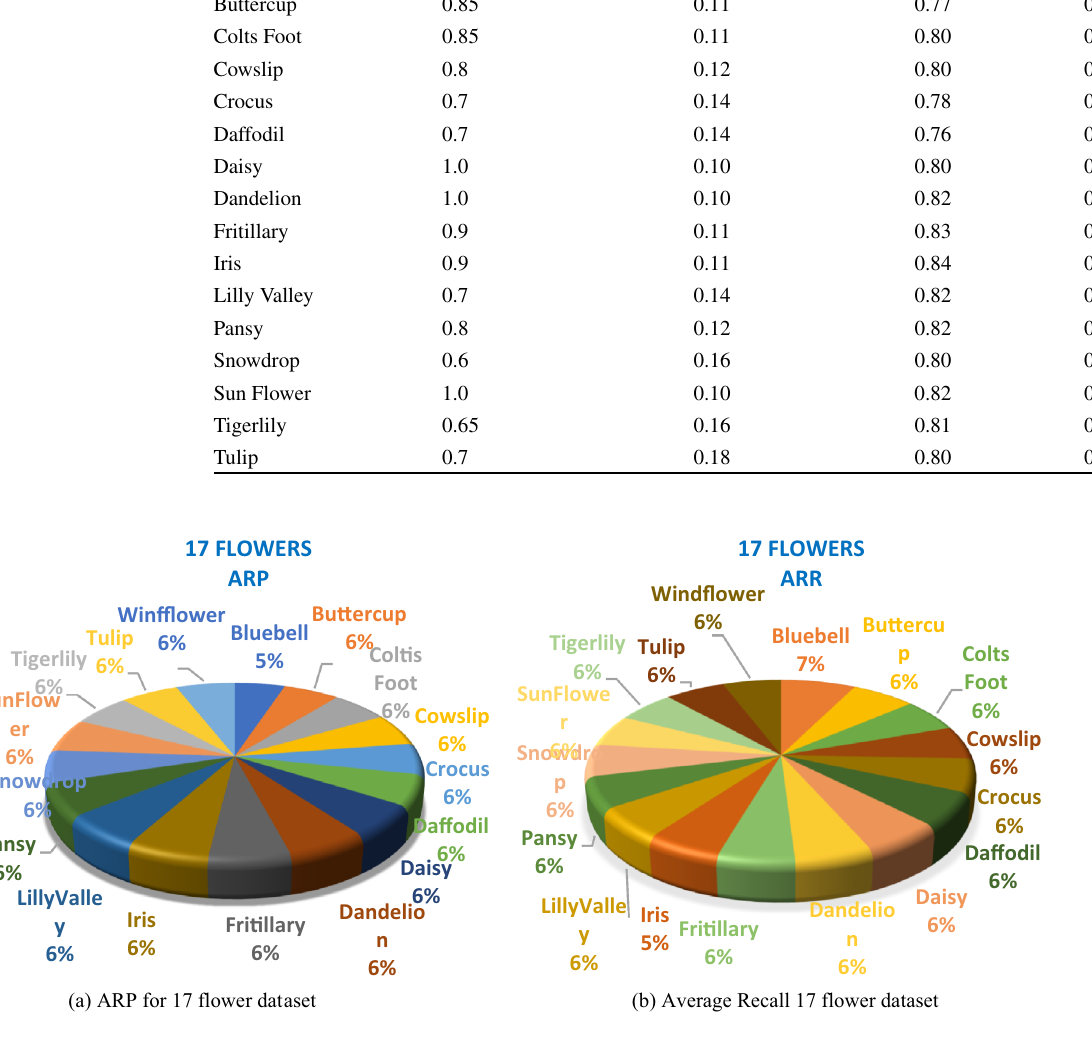
Fig. 10 a ARP for 17 flower dataset. b Average recall 17 flower dataset